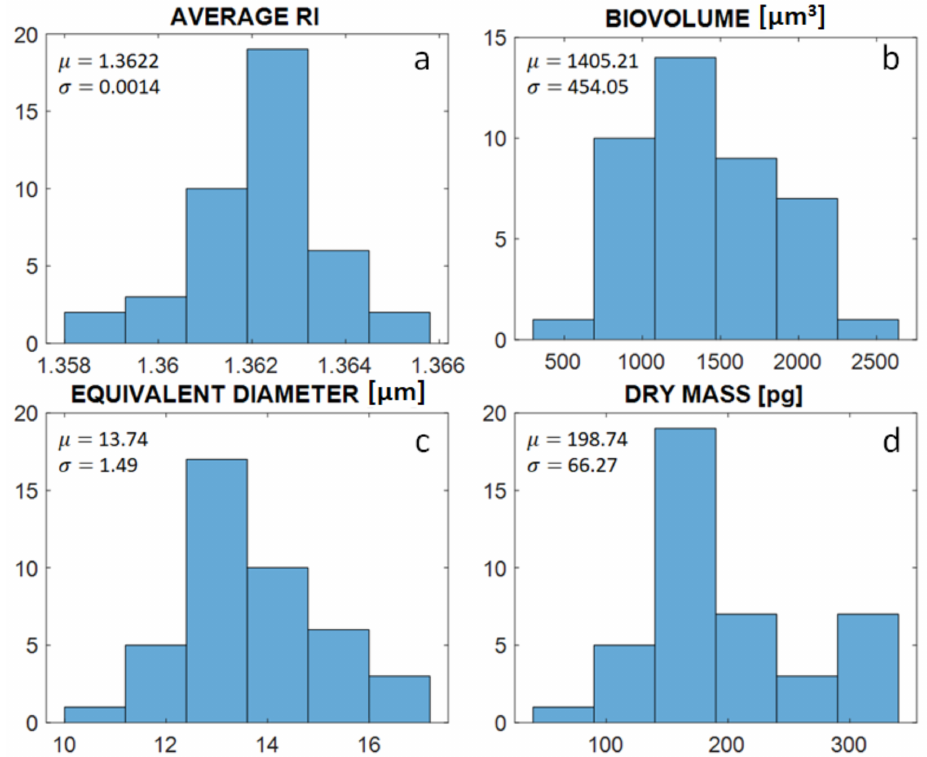
Figure 5. Histograms computed over the monocytes under examination; ( a ) average refractive index, ( b ) biovolume, ( c ) equivalent diameter, ( d ) dry